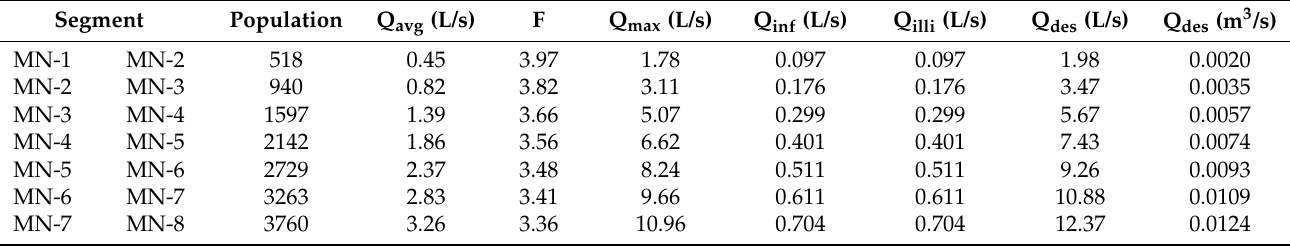
Table 7. Design flow rates for expansion zone